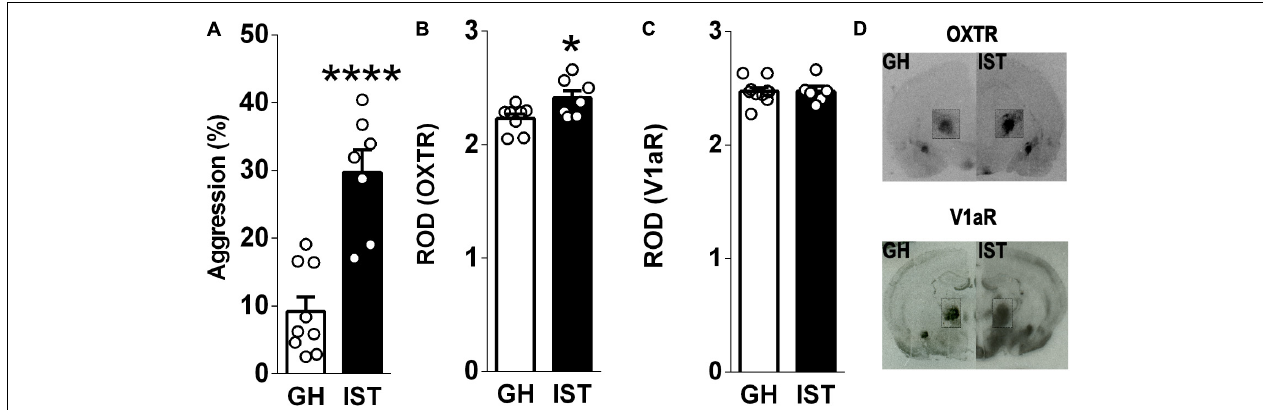
FIGURE 2 | Isolated and trained (IST) female Wistar rats showed exacerbated aggression (A) accompanied by increased oxytocin (OXTR, B, D , insert) but not vasopressin 1a (V1aR, C, D , insert) receptor binding in the central amygdala. Data are shown as relative optical density (ROD). Data presented as mean + s.e.m. * p < 0.05, **** p < 0.0001 vs